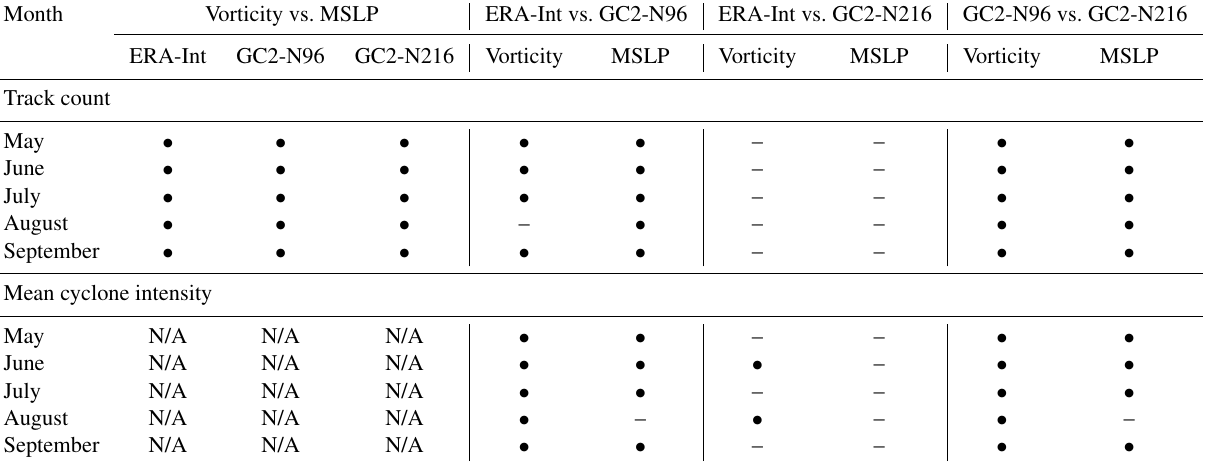
Table 1. Results of the two-sample Kolmogorov–Smirnov test for comparison of frequency distributions of monthly whole-Arctic cyclone track count and mean cyclone intensity. Results are given for comparison of frequency distributions for vorticity- and MSLP-based tracking for ERA-Interim, GC2-N96 and GC2-N216. For each of the two tracking methods, results are also given for comparison of different pairs of ERA-Interim, GC2-N96 and GC2-N216. Circles ( • ) denote pairs of distributions which can be said to be different with at least 95% confidence, while dashes (–) mean the distributions cannot be said to be different at this confidence level. As discussed in the text, it was not possible to compare directly the frequency distributions of mean cyclone intensity from the two tracking methods; hence, these are marked “N/A”